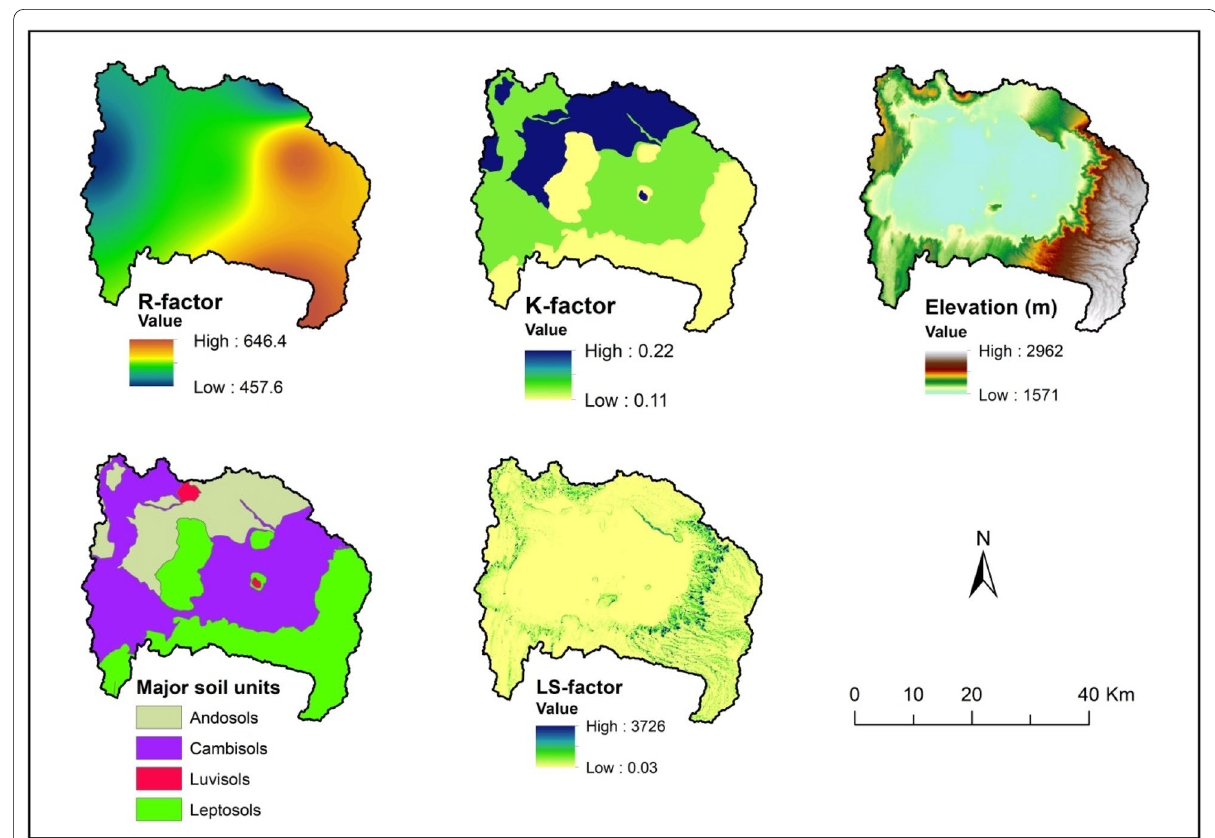
Fig. 3 Spatial distributions of R-factor, K-factor, elevation, major soil units, and LS-factor